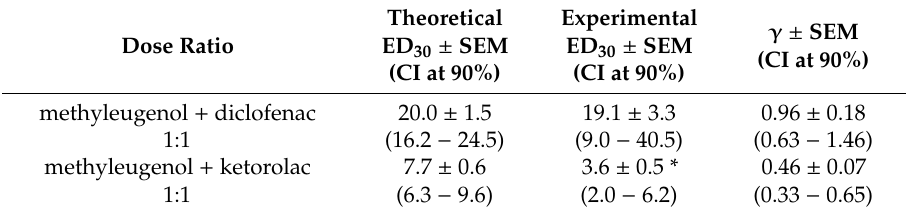
Table 2. Statistical analysis of the e ff ects produced on mice by the administration of methyleugenol plus diclofenac and methyleugenol plus ketorolac. The experimental values were determined by the formalin test.